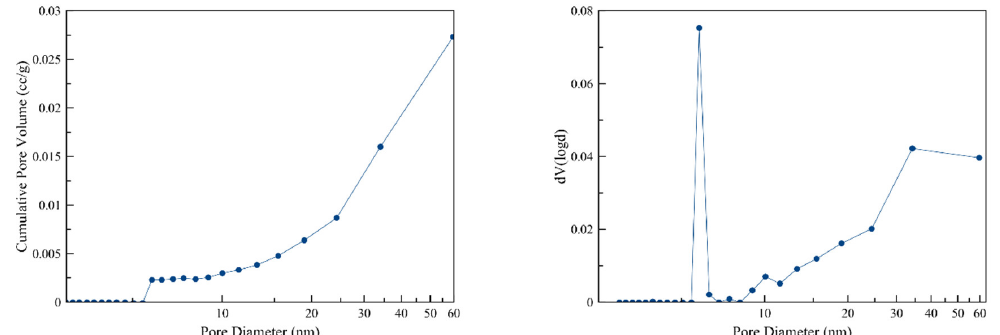
Figure 3. Cumulative pore volume ( left ) and pore size distribution of NZU ( right ).